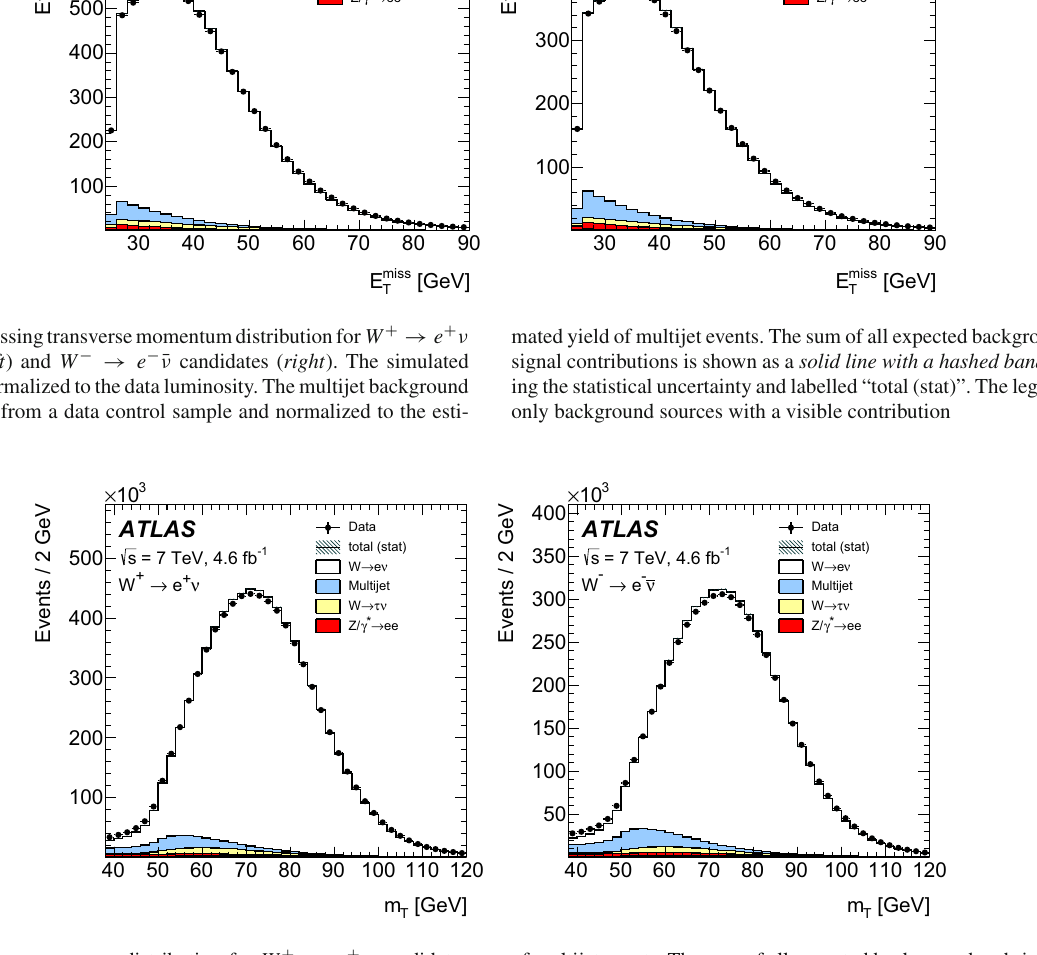
m40 [GeV] T Fig. 6 The transverse mass distribution for W + → e + ν candidates of multijet events. The sum of all expected background and signal con- tributions is shown as a solid line with a hashed band detailing the ( left ) and W − → e − ¯ ν candidates ( right ). The simulated samples are normalized to the data luminosity. The multijet background shape is statistical uncertainty and labelled “total (stat)”. The legend lists only background sources with a visible taken from a data control sample and normalized to the estimated yield